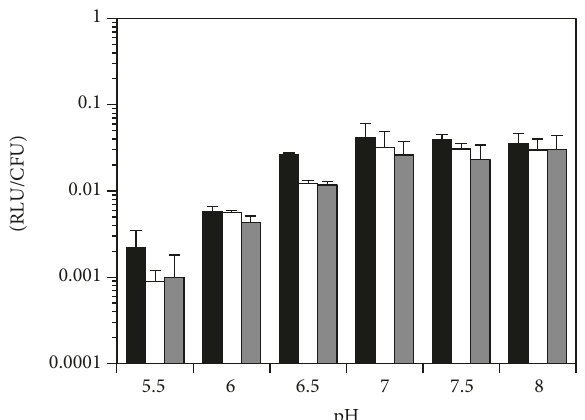
Figure 1: Effects of pH on fimA (black column), fimB (white column), and fimE (gray column) expression as determined with luxABCDE transcriptional fusions in strain NU149. RLU/CFU were measured with a luminometer and then divided by viable counts; means ± standard deviations are indicated from at least three separate